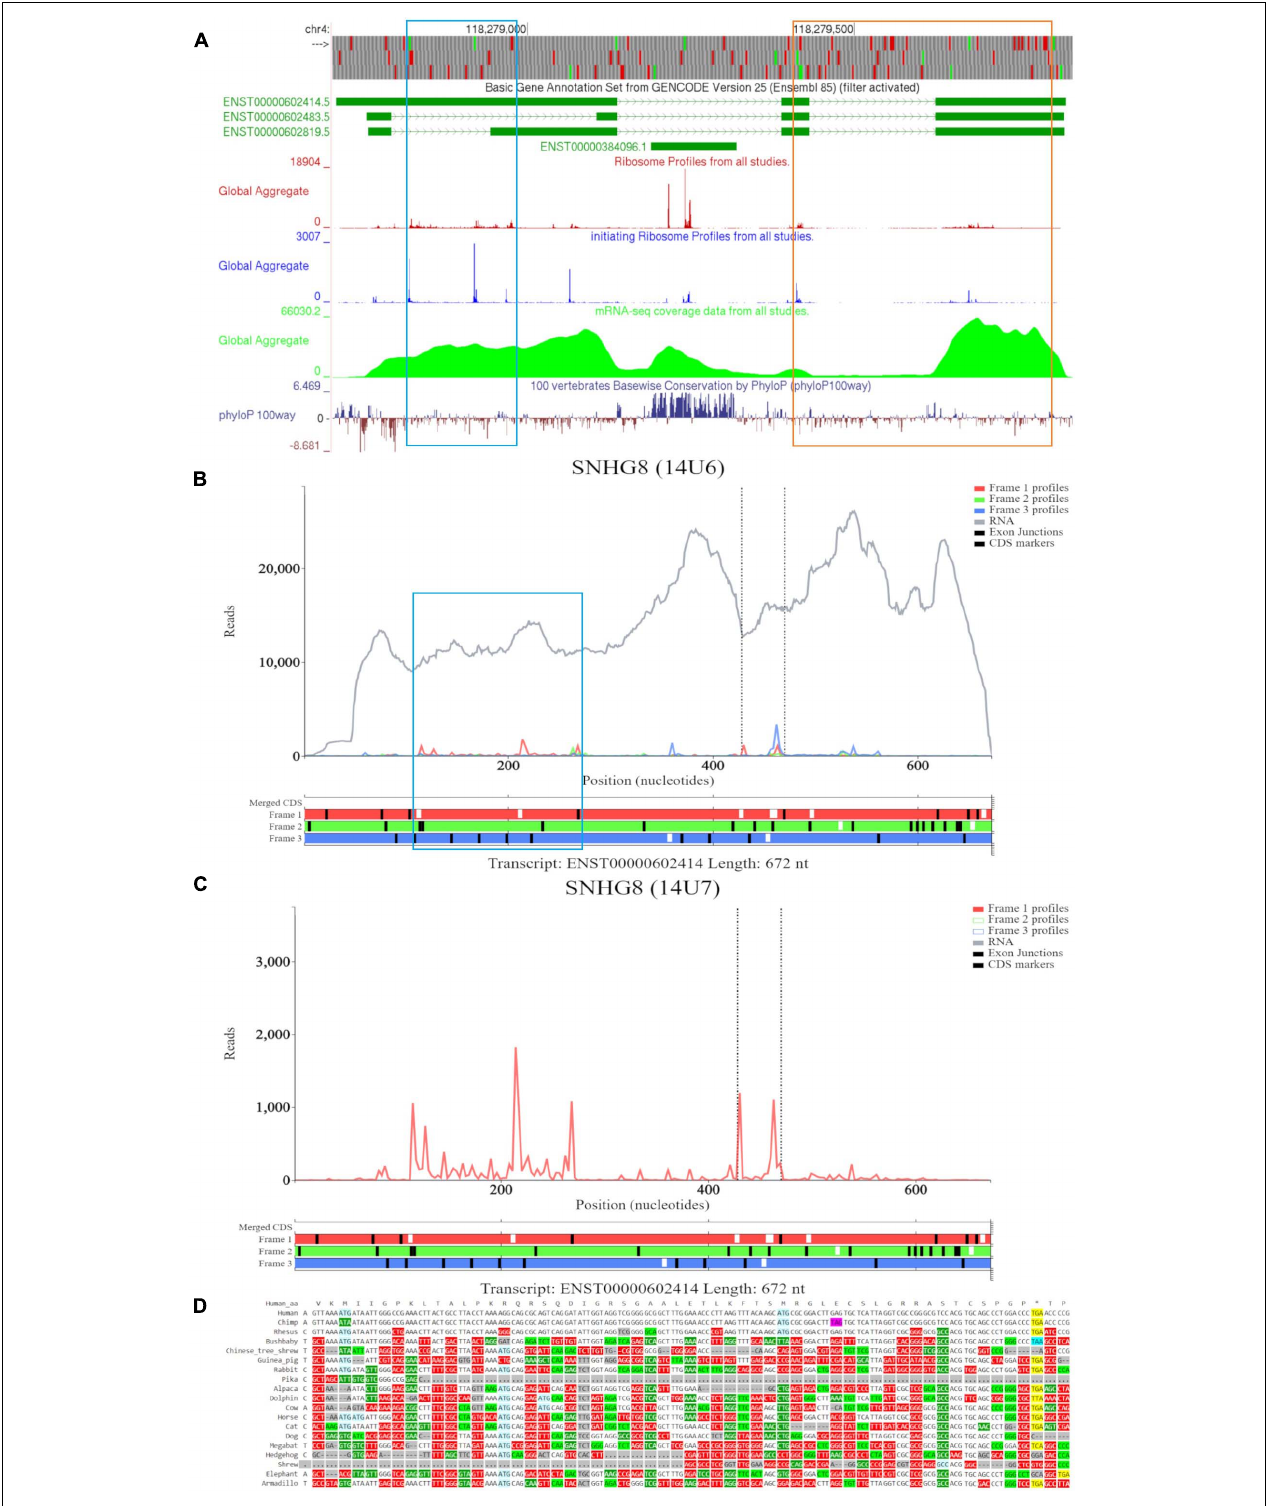
FIGURE 4 | Visualization of SNHG8 in Trips-Viz, GWIPS-Viz and CodAlignView. (A) Visualization of SNHG8 in GWIPS-viz with the tracks described in Setup and Configurations enabled. Two translated ORFs are outlined in blue and orange, respectively. (B) Visualization of SNHG8 isoform ENST00000602414 in Trips-viz. The ORF previously outlined in blue in GWIPS-viz is similarly outlined again. (C) Visualization of transcript ENST00000602414 without RNA-seq data enabled and only reading frame 1 enabled. (D) CodAlignView for the ORF previously outlined in blue showing a high ratio of radical non-synonymous codon substitutions.